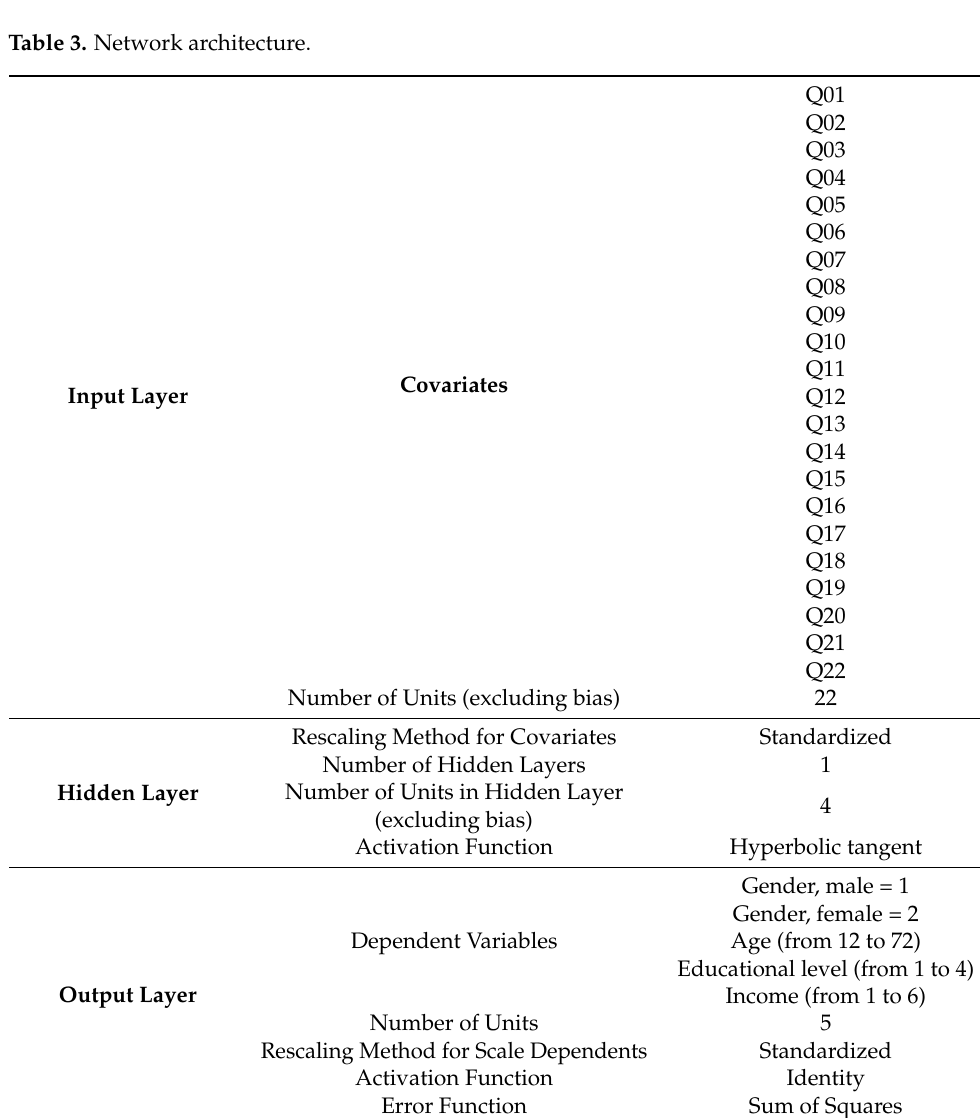
Table 3. Network